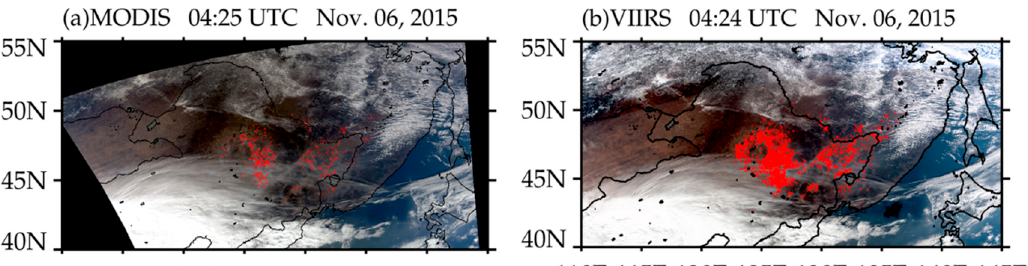
Figure 2. Composited RGB (Red, Green, Blue) true-color images overlaid with fire locations (red dots) of the fire case in Northeast Asia: ( a ) MODIS on 6 November 2015 (04:25 UTC); ( b ) VIIRS on 6 November 2015 (04:24 UTC).